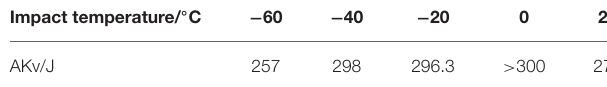
TABLE 6 | Results of Charpy V-notch FATT tests.